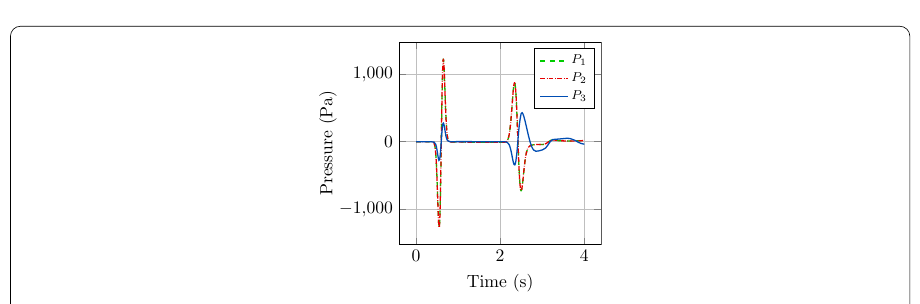
Fig. 7 Elastic wave propagation in a homogeneous isotropic medium (absolute value of the pressure field)